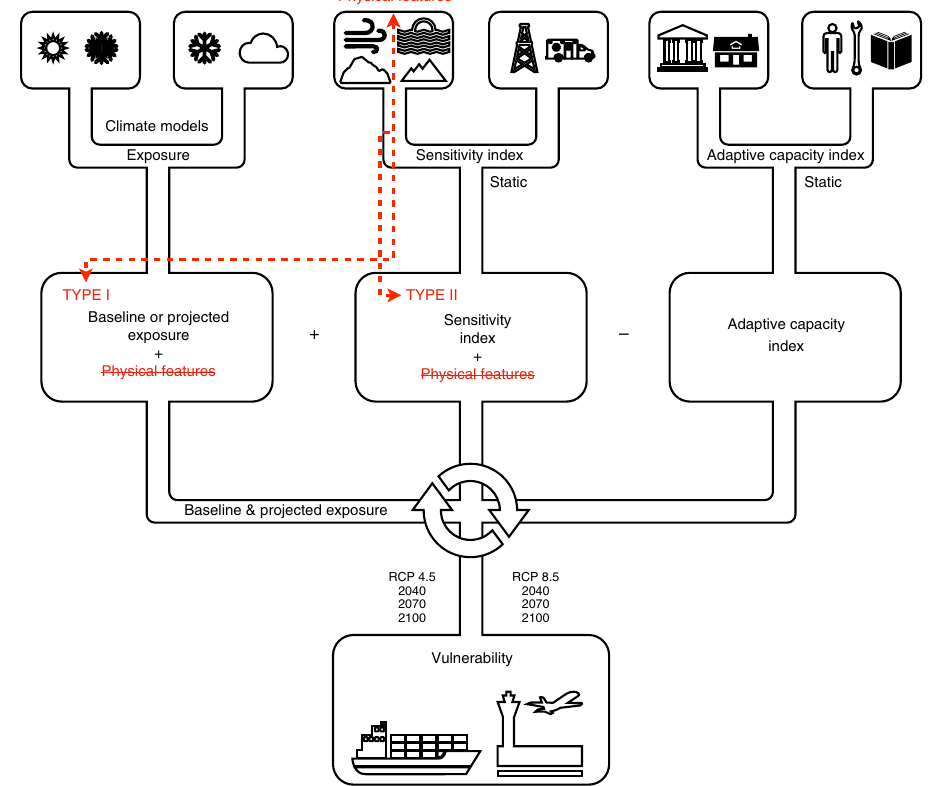
Fig. 8 Vulnerability model type I was calculated for all 50 communities for present, 2040, 2070, and 2100 timeframes under RCP 4.5 and 8.5 scenarios. Model was run using climate variables and extreme indices and for each sensitivity indices pairing (airport-disasters or marine-disasters). Under the Type I model, exposure projections and physical features were calculated together, then added to sensitivity (marine or